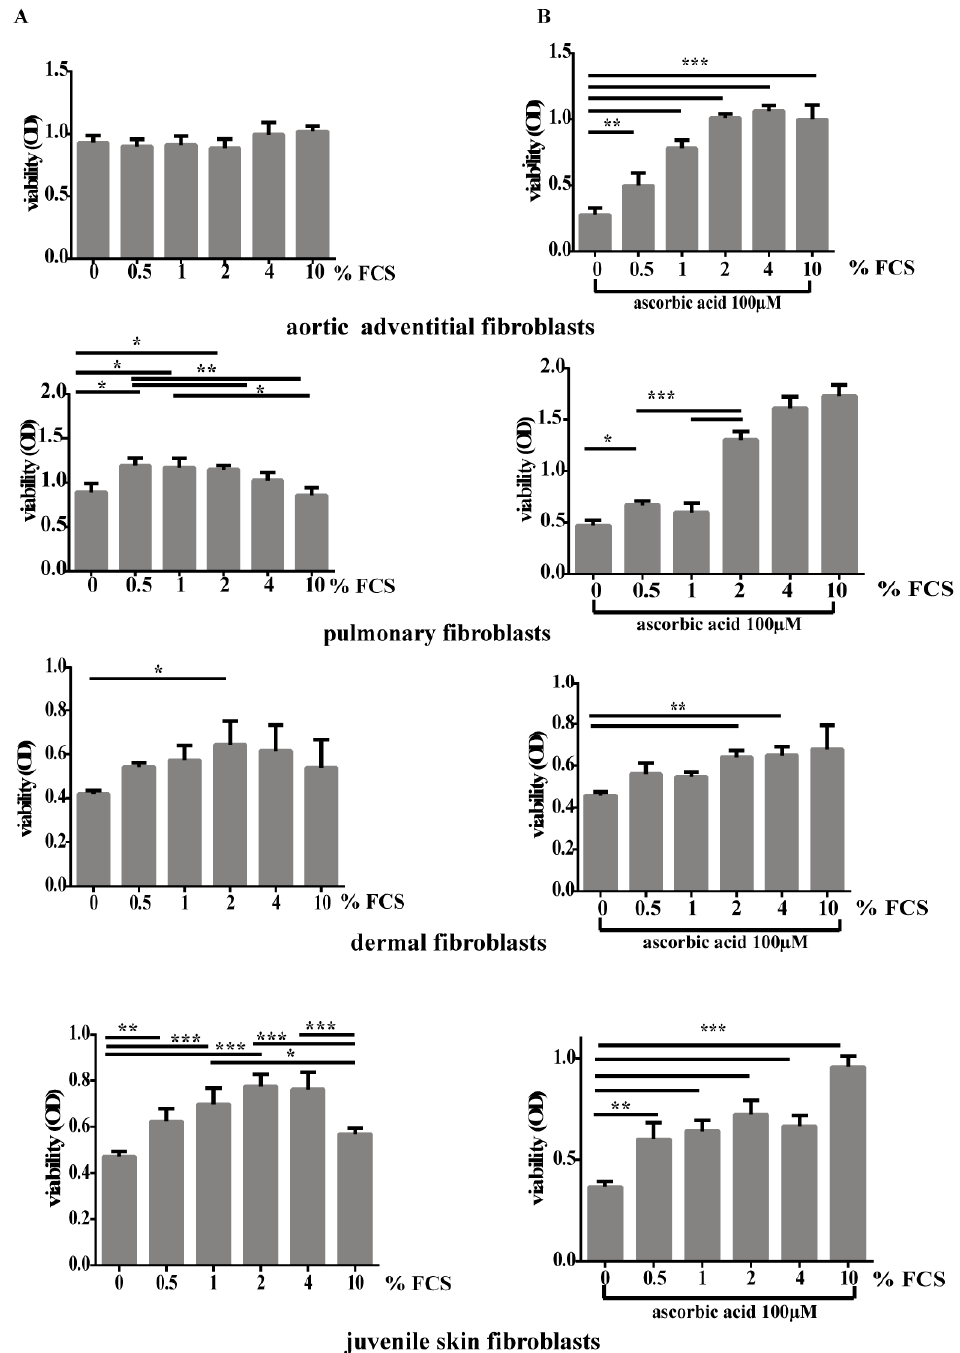
Figure 4. Determination of viability in different fibroblast types with increasing FCS concentrations with or without AA. ( A ) Incubation of AoAF, lung, adult dermal and juvenile skin fibroblasts with different concentrations of FCS increases viability, with the exception of AoAFs. ( B ) in contrast incubation of cells with AA without FCS reduces the cell viability, but addition of FCS increases viability to normal levels. Columns and error bars represent the mean and SD of optical density. * p < 0.05, ** p < 0.01, *** p <